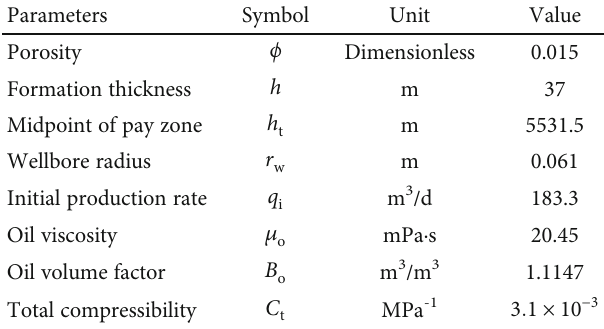
Figure 14: In fl uence of dimensionless radial distance of external boundary, r Table 2: Basic input parameters for validation case